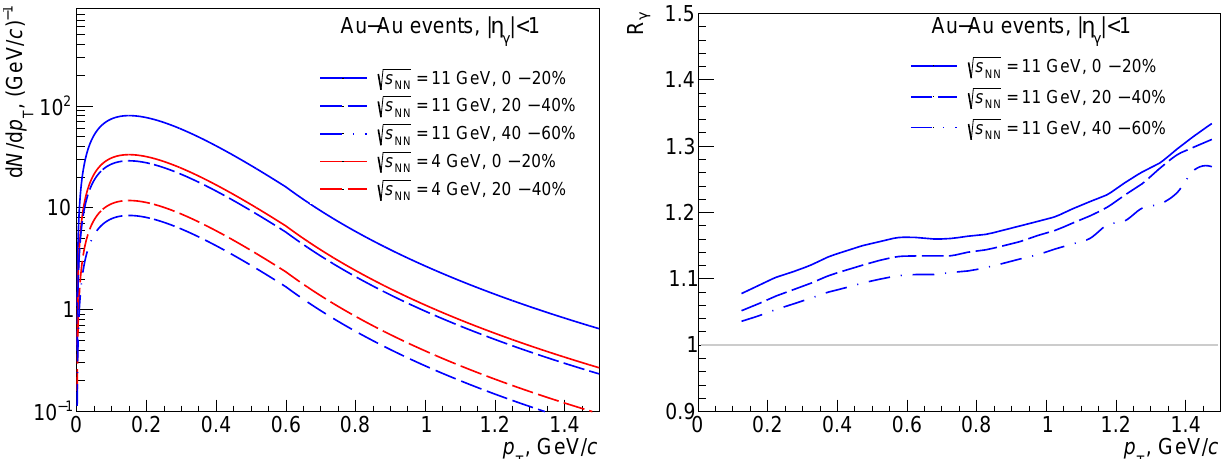
Figure 9. The expected direct photon spectra ( left ) and excess photon ratio R γ ( right ) as a function of the photon transverse momentrum in Au-Au collisions at NICA